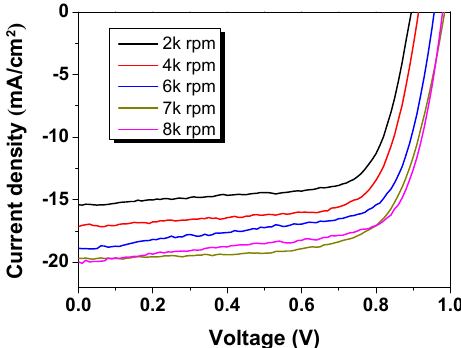
Figure 1. Current density–voltage ( J – V ) characteristics of perovskite solar cell (PSC) devices based on poly(3,4-ethylenedioxythiophene):poly(styrene sulfonate) (PEDOT:PSS) hole transport layer (HTL) with different coating speeds.